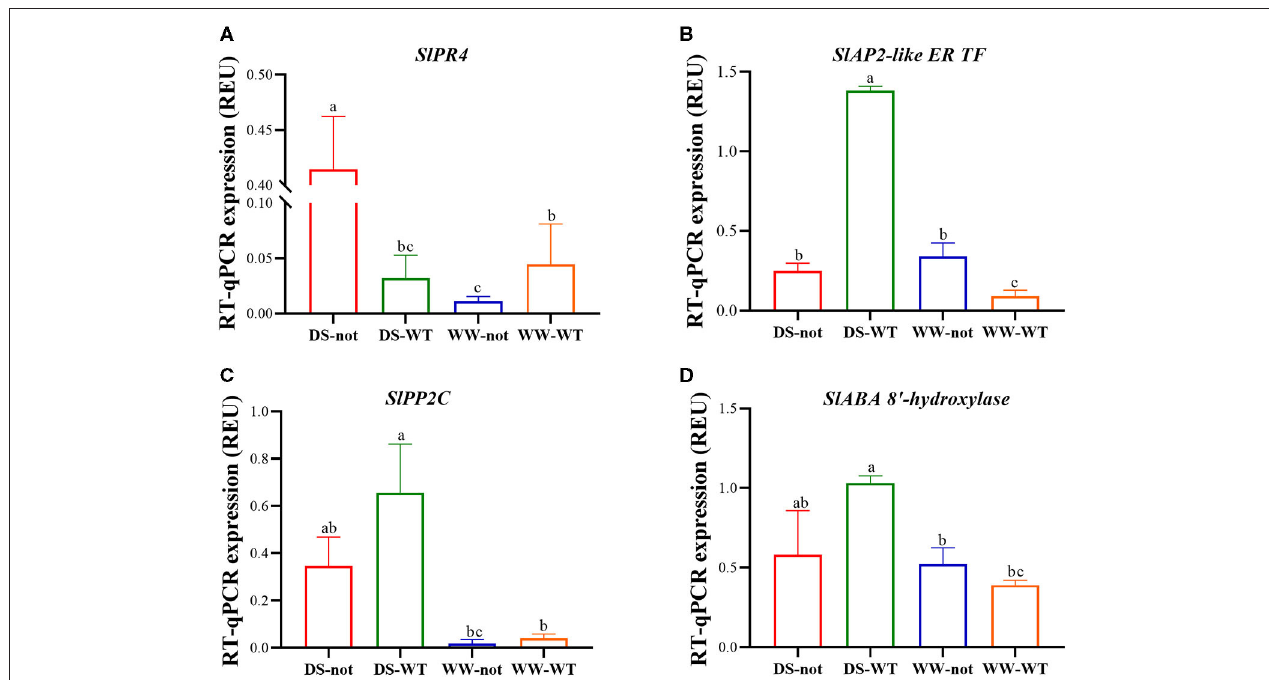
FIGURE 4 | Root expression of genes encoding the Solanum lycopersicum ( Sl ) pathogenesis-related protein 4 ( SlPR 4 ) (A) and APETALA2-like ethylene-responsive transcription factor ( SlAP2-like ER TF ) (B) , protein phosphatase 2C ( SlPP 2C ) (C) , abscisic acid 8 ′ -hydroxylase ( SlABA 8 ′ -hydroxylase ) (D) based on RT-qPCR data. Columns represent the relative expression levels of genes with different treatments. Bars on top of the columns represent the mean ± standard error (s.e.) of three biological replicates. The ubiquitin gene was used as an internal control to normalize the expression levels. Significantly different ( p ≤ 0.05) expression levels with different treatments are indicated with different